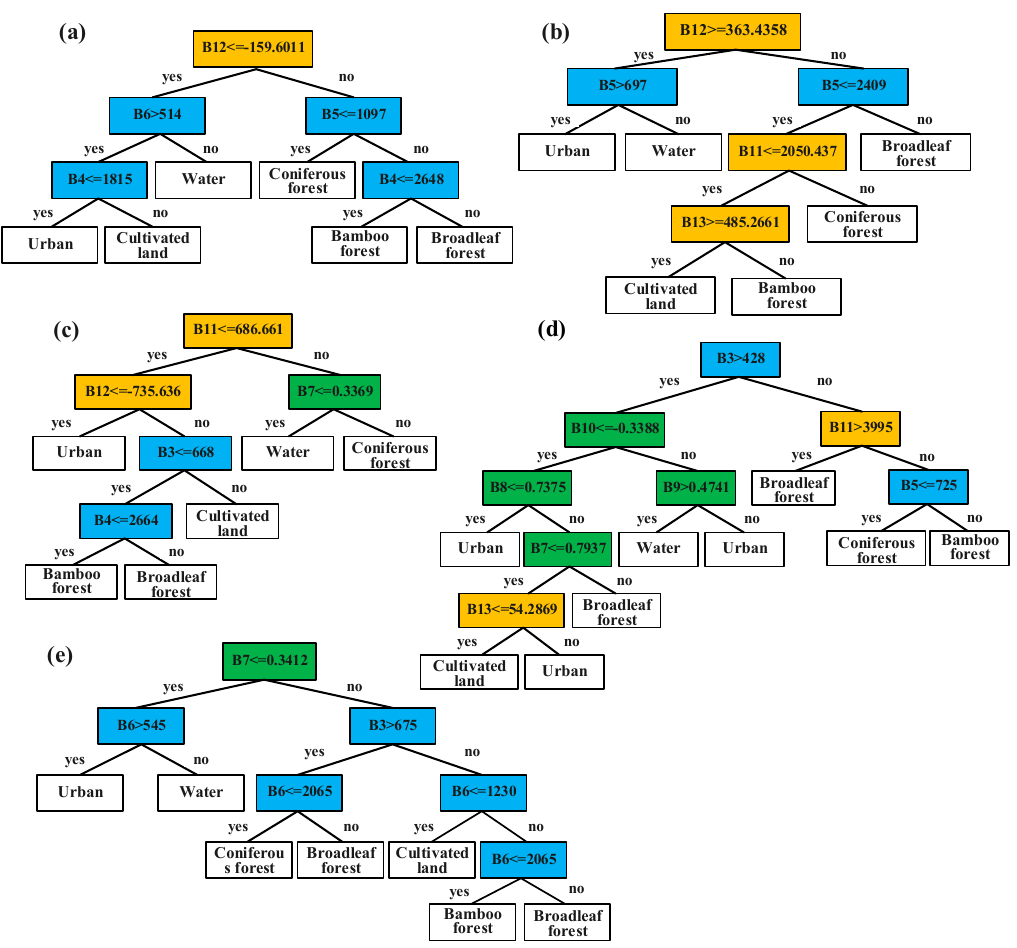
Figure 2. Optimal decision trees of image classification from 1995 to 2015 ( a – e